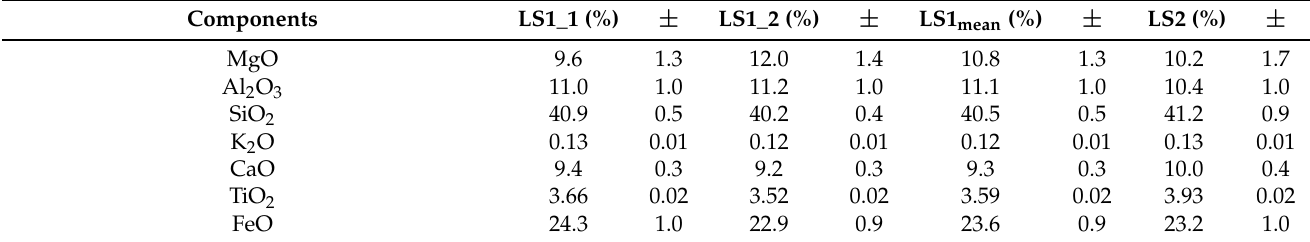
Table A2. Chemical compositions with their 1 σ statistical errors in wt.%, normalized to 99% on account of missing elements, such as Mn, Ni, Cr, P, and Na. The particle size is assumed to be 10 µ m. Components